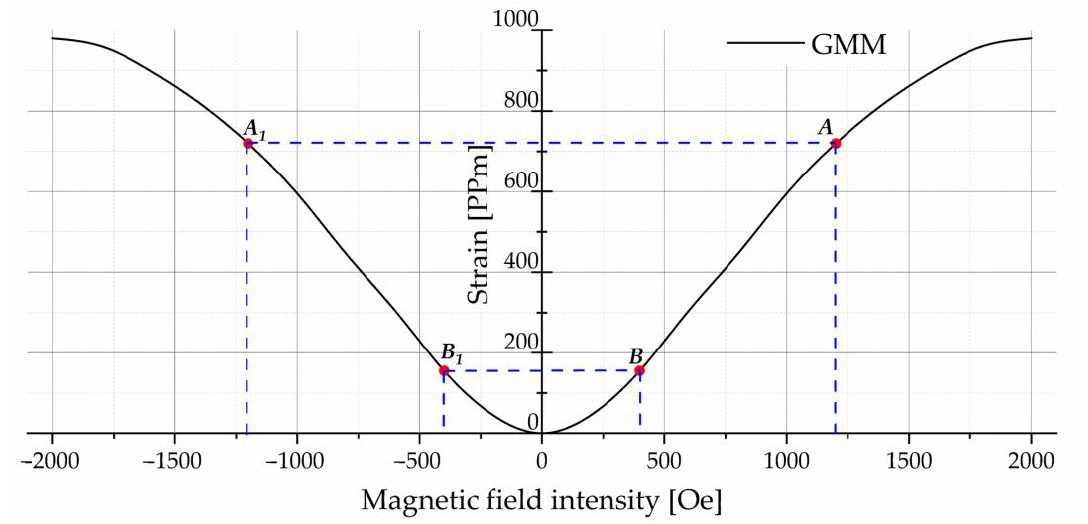
Figure 2. Relationship between the strain of GMM and the magnetic field intensity.